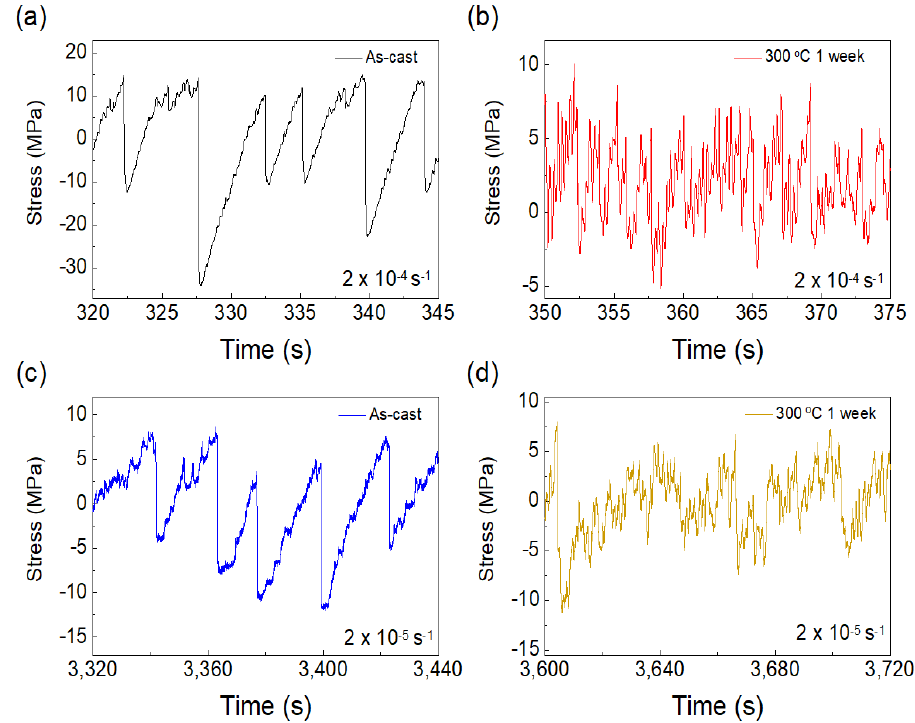
Figure 3. Graphs for the detrended stress vs. time curves for the ( a ) as-cast Zr 52.5 Cu 17.9 Ni 14.6 Al 10 Ti 5 BMG compressed at a strain rate of 2 × 10 − 4 s − 1 , ( b ) thermally-annealed (300 ◦ C, 1 week) Zr 52.5 Cu 17.9 Ni 14.6 Al 10 Ti 5 BMG compressed at a strain rate of 2 × 10 − 4 s − 1 , ( c ) as-cast Zr 52.5 Cu 17.9 Ni 14.6 Al 10 Ti 5 BMG compressed at a strain rate of 2 × 10 − 5 s − 1 , and ( d ) thermally-annealed (300 ◦ C, 1 week) Zr 52.5 Cu 17.9 Ni 14.6 Al 10 Ti 5 BMG compressed at a strain rate of 2 × 10 − 5 s − 1 .